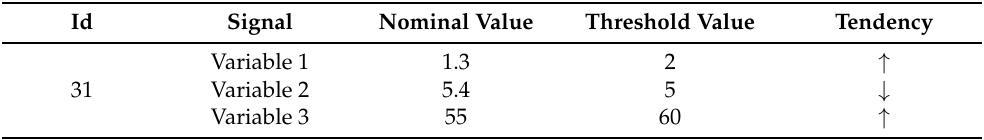
Table 1. Example of failure mode identified by the failure mode, effects and criticality analysis (FMECA). This failure mode has an Id 31 and comprises three signals. Values shown do not corre- spond to any real failure mode. Id Signal Nominal Value Threshold